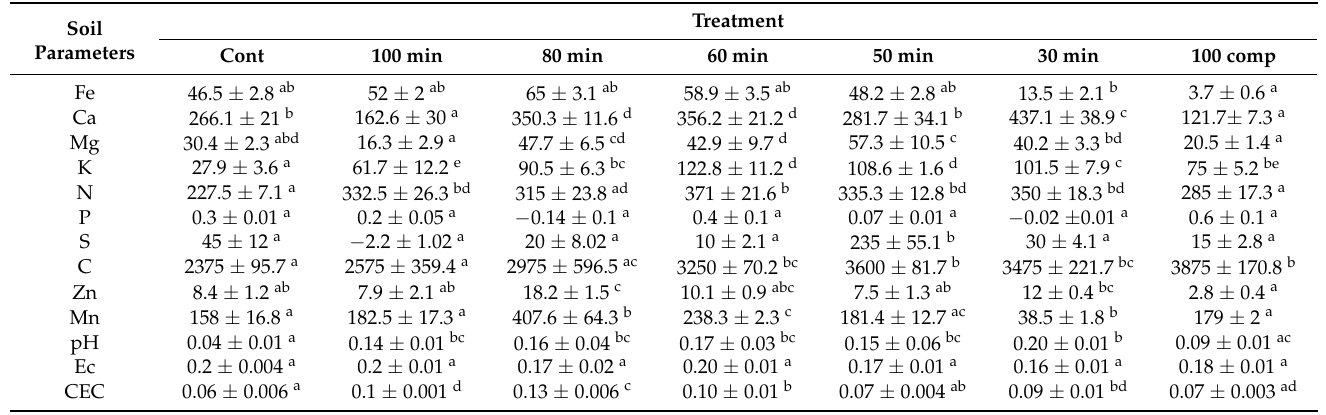
Table 1. Soil minerals (mg kg − 1 soil) and chemical properties (0–20 cm) after harvest in different treatments (2018–2020) (mean ±